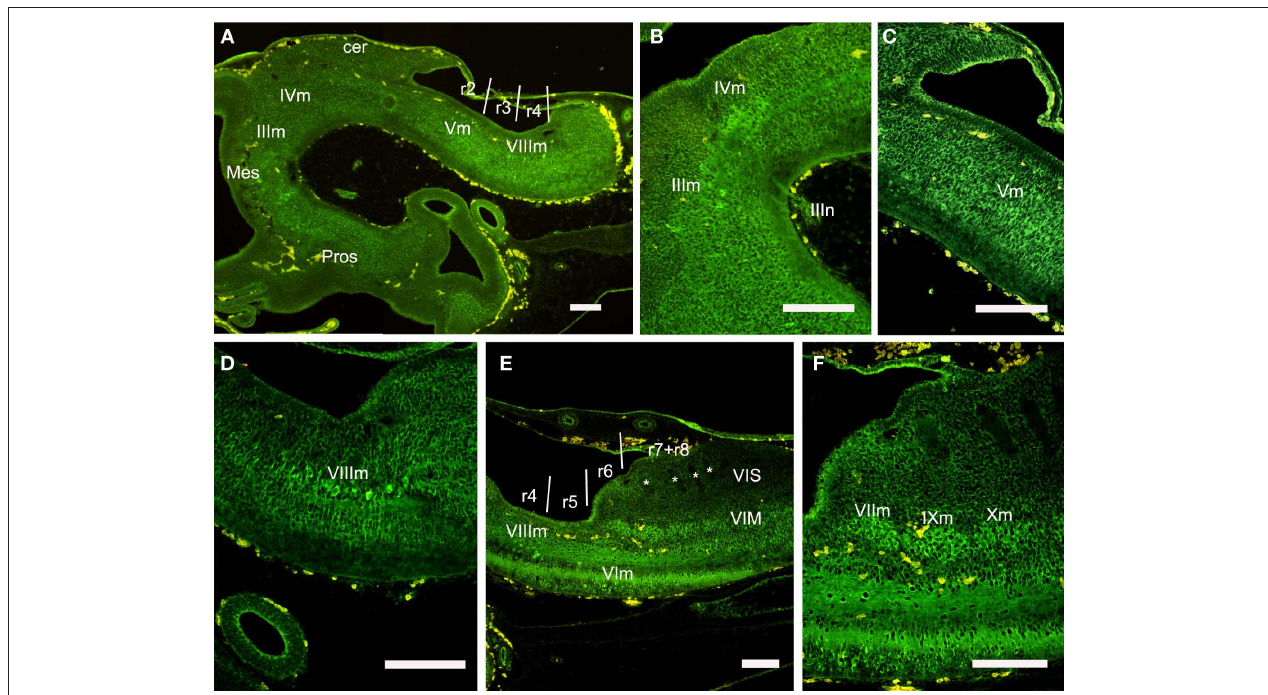
nucleus (C) , and magnocellular octaval nucleus (D) . (e,F) Panoramic view and detail of ChAT-ir cells in the visceromotor column. Asterisks label the negative roots of